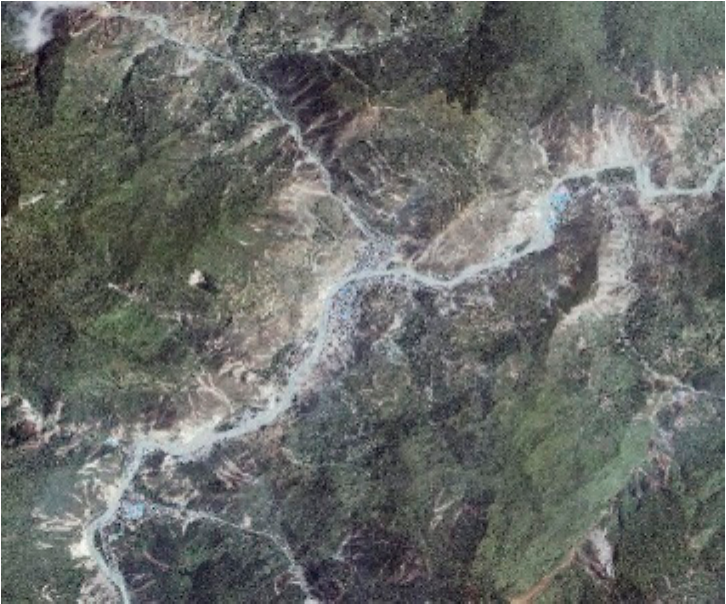
Figure 11. The research area of this study (Wenchuan).